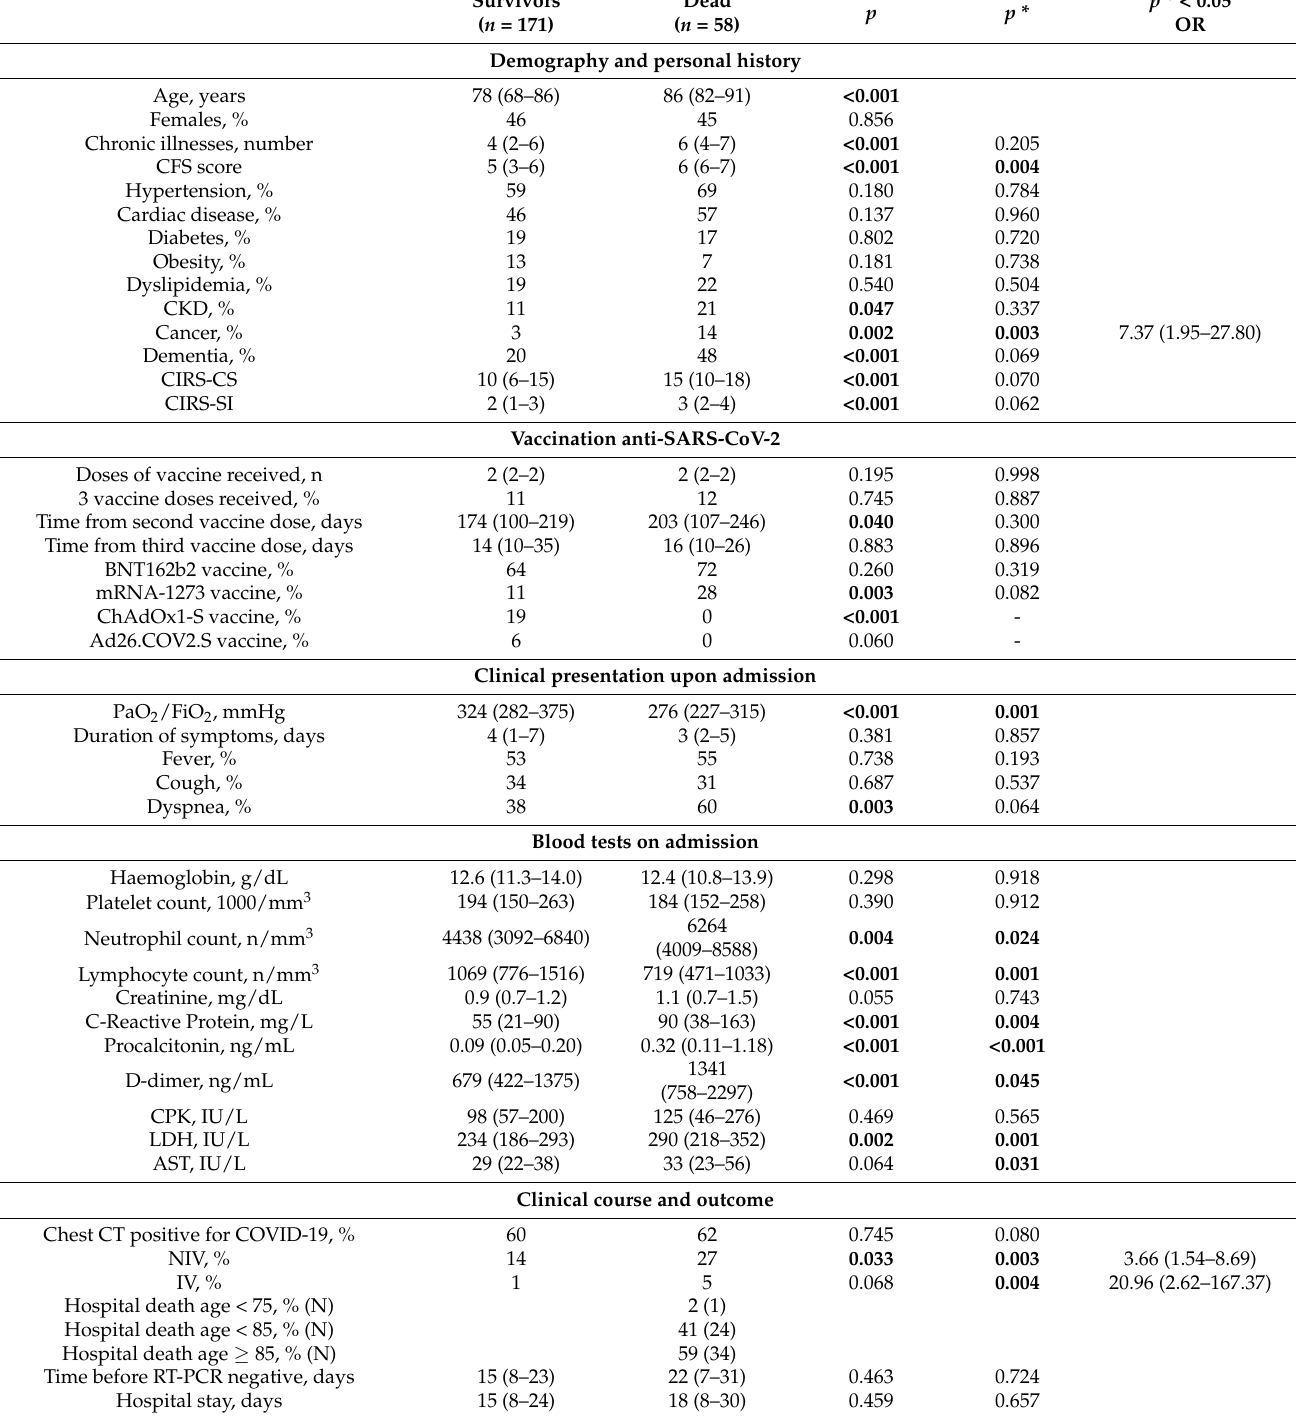
Table 2. Comparison of the clinical and laboratory characteristics of patients with breakthrough infection categorized by hospital outcome (survival vs.